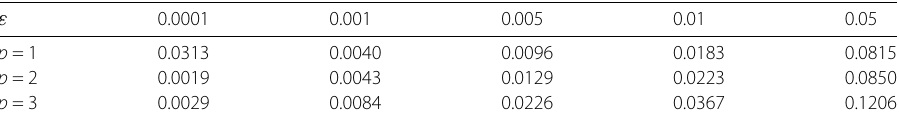
Table 3 k = 0.5, the relative root mean square errors (cid:10) ( v ) for various noise levels ε